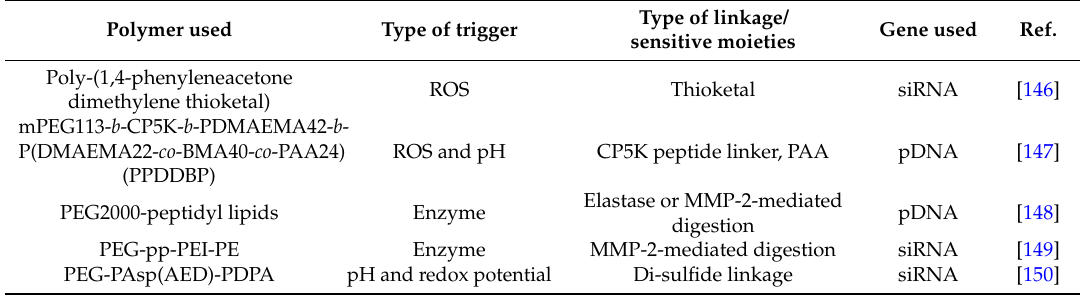
Table 4. ROS, enzyme and multi-stimuli responsive polymer preparations used for gene